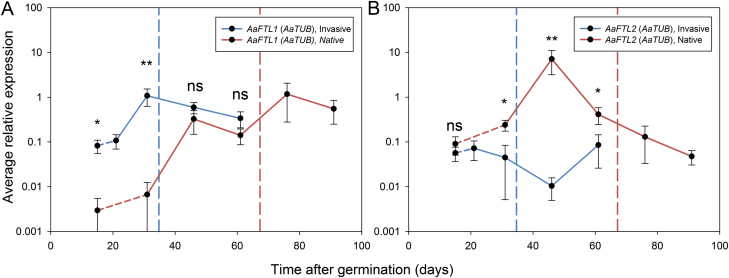
Expression of AaFTL1 and AaFTL2. Data points indicate average expression values for AaFTL1 (A) and AaFTL2 (B) of plants from the invasive (blue) and native population (red), respectively. The expression shown here is based on four (native) or 10 (invasive) biological replicates, each with three technical replicates. The data for the 15 DAG time point were obtained in a separate experiment with four pools of four plants each as biological replicates. Error bars show the SE. AaTUB was used as a reference gene. Mann–Whitney U-tests were performed to test for significant differences between populations (ns P>0.05, *P<0.05, **P<0.01). The vertical dashed lines indicate the average male floral initiation time for the invasive (blue) and the native population (red), respectively.